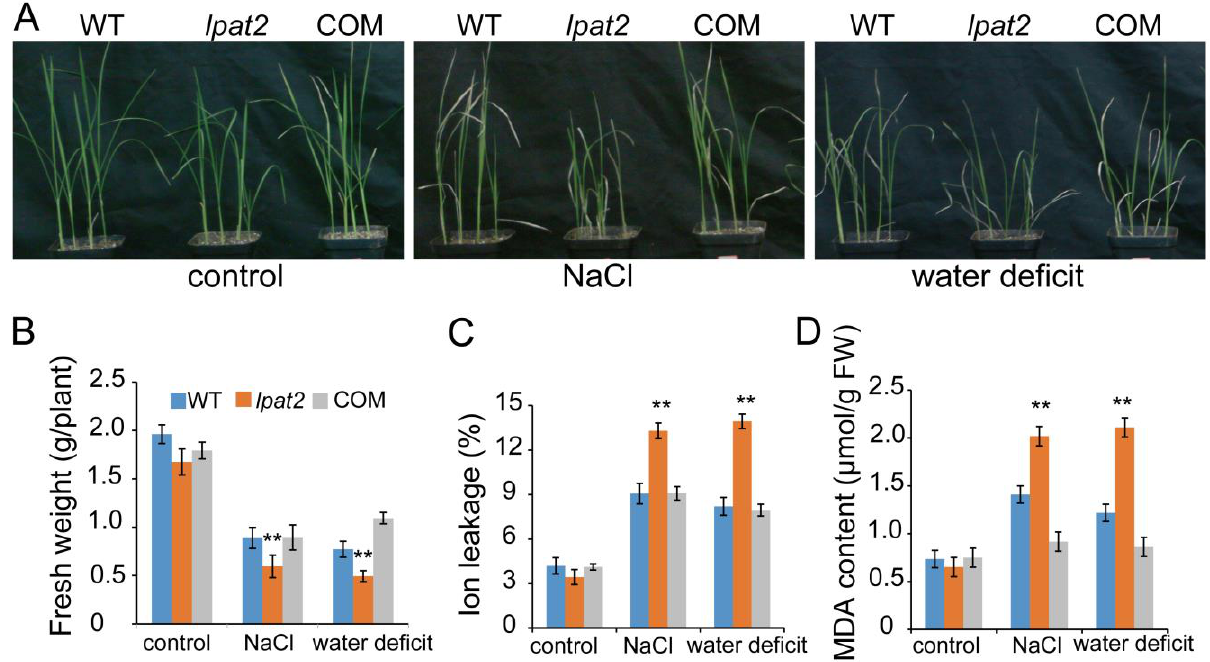
Figure 2. Suppressed LPAT2 led to reduced tolerance to salt and drought stresses. ( A ) Seedling growth phenotypes under the control, salt stress, and water deficit conditions. Three-week-old plants were treated with salt stress (150 mM NaCl) for 12 days, or water deficit (stopped watering for 10 days until leaves of wild type (WT) plants began wilting when the soil water content was approximately 11%). ( B ) The shoot fresh weight of plants shown in ( A ). Values are means ± SD ( n = 10) from one of three independent experiments. ( C ) Ion leakage in leaves. Values are means ± SD ( n = 3). ( D ) Malonaldehyde (MDA) content in leaves. Values are means ± SD ( n = 3). Control, plants without stress treatment; COM, LPAT2 genetic complementation. ** indicates significant difference at p < 0.01 compared to WT plants based on Student’s t test.